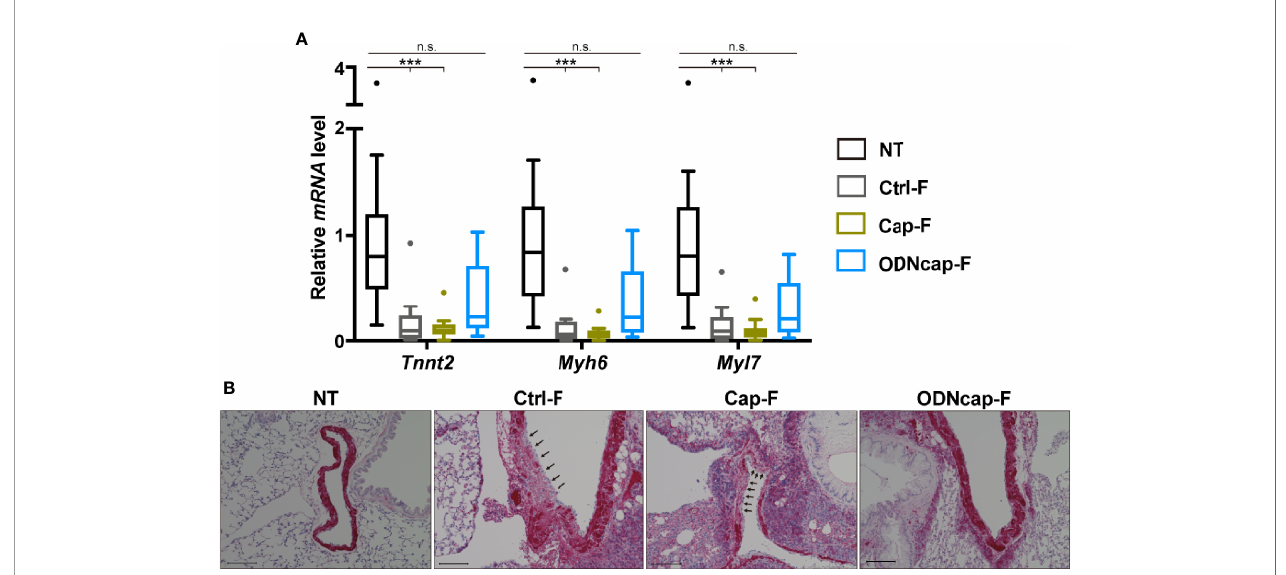
FIGURE 6 | ODNcap-F protects pulmonary vein cardiomyocytes from allergic injury. Lung total RNA and sections were prepared on Day 70. (A) Expression levels of cardiac muscle-speci fi c genes in the lung were measured by real-time quantitative PCR ( n = 12). Data are shown as Tukey ’ s box plots. *** P < 0.001; n.s., not signi fi cant by Kruskal – Wallis test with Dunn ’ s multiple comparisons. (B) Lung sections prepared on Day 70 were stained with anti-cardiac muscle troponin T (cTnT) antibody ( n = 6). Representative images are shown. Positive reaction of the antibody (red) was observed around the large pulmonary veins. Injured areas (arrows) of the cTnT-positive cells were observed in Ctrl-F and Cap-F, but not in NT or ODNcap-F. Scale bars, 100 m